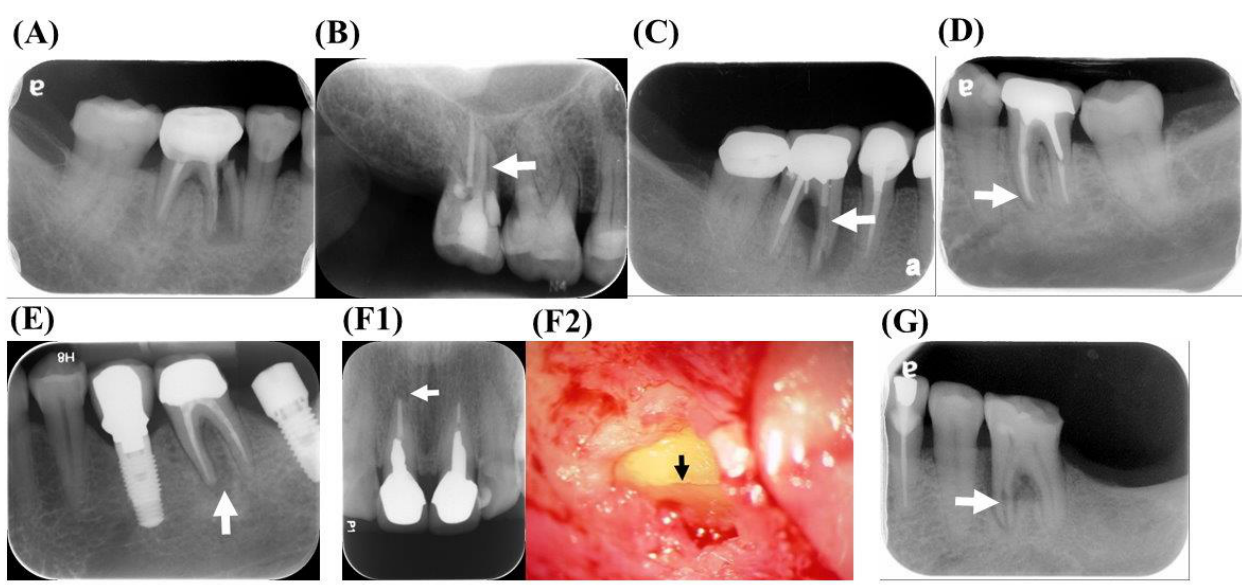
Figure 5. Radiographic features of the VRFs. ( A ) Displacement of fractured root fragment, ( B ) radiolucent lines within the root canal (white arrow), ( C ) unusual radiolucent space between the canal wall and intracanal material (white arrow), ( D ) widening of the periodontal ligament (PDL) space (white arrow), ( E ) periradicular radiolucent halo (white arrow), ( F1 ) root resorptions corresponding to the fracture line (white arrow); ( F2 ) VRF was further diagnosed via exploratory surgery (black arrow) and ( G ) a widening of the root canal space (white arrow).